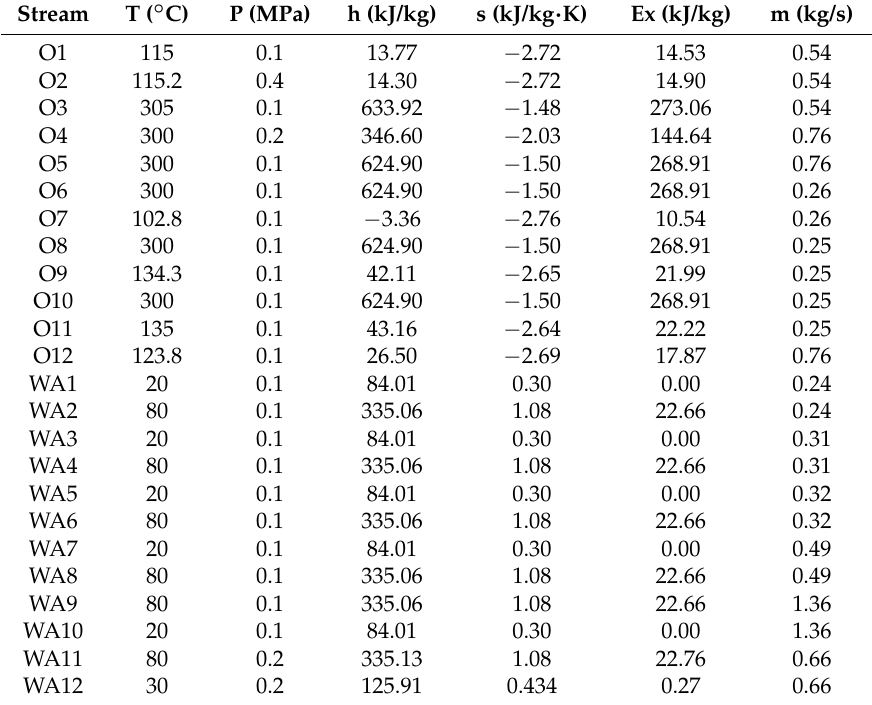
Table 6. Thermodynamic parameters of water and Therminol VP-1